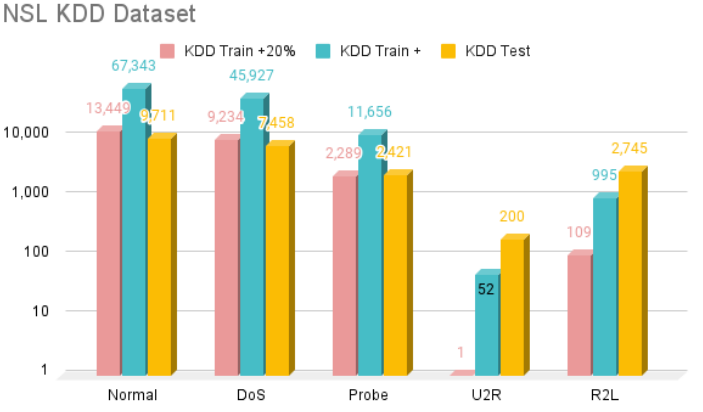
Figure 3. NSL-KDD dataset.